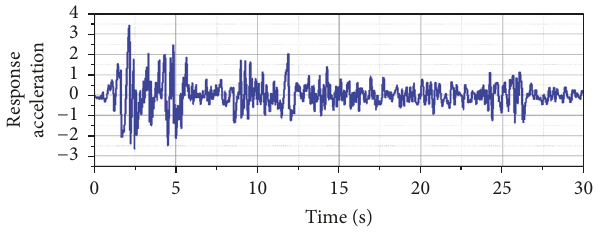
Figure 11: EI-Centro earthquake